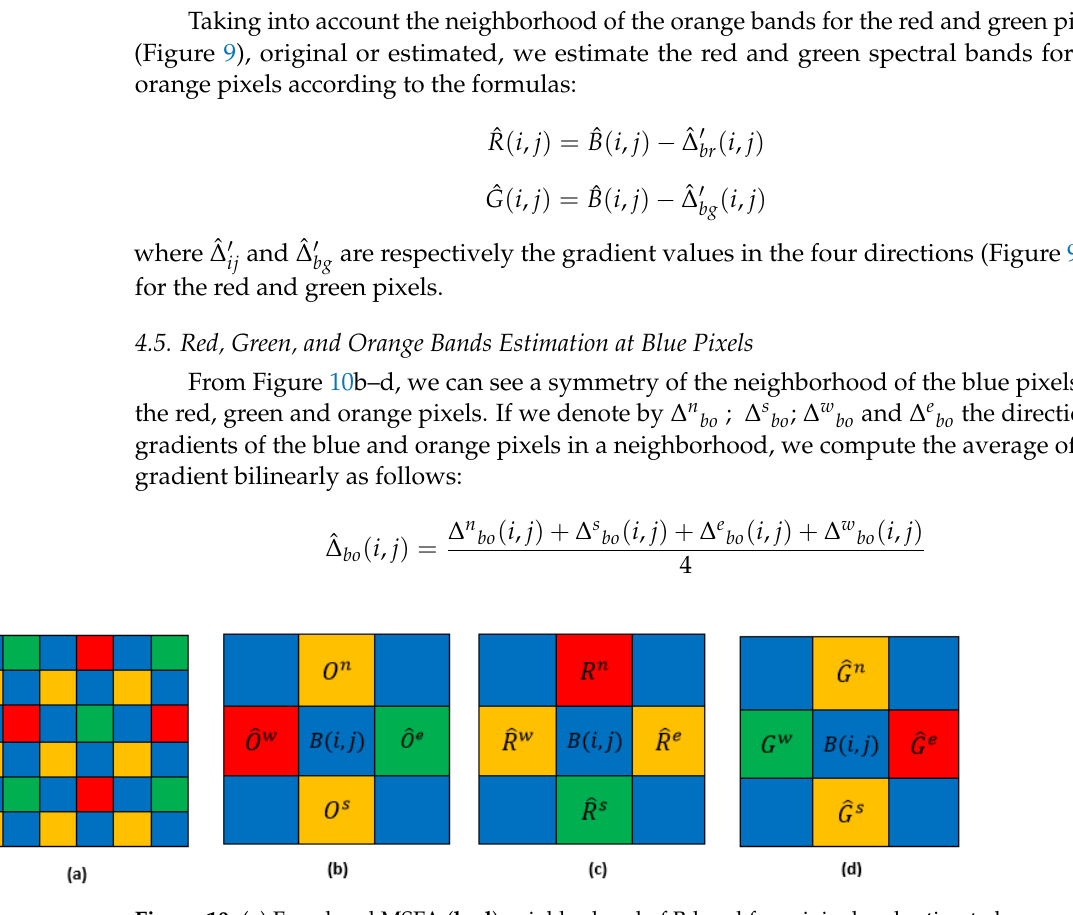
Figure 10. ( a ) Four ‐ band MSFA ( b – d ) neighborhood of B ‐ band for original and estimated orange, red and green